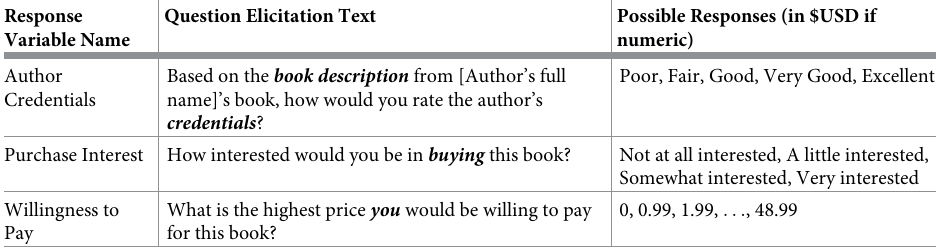
Table 2. Response variables. The three dependent variables measured in our study along with the specific question text and their possible measurement values. Response Variable